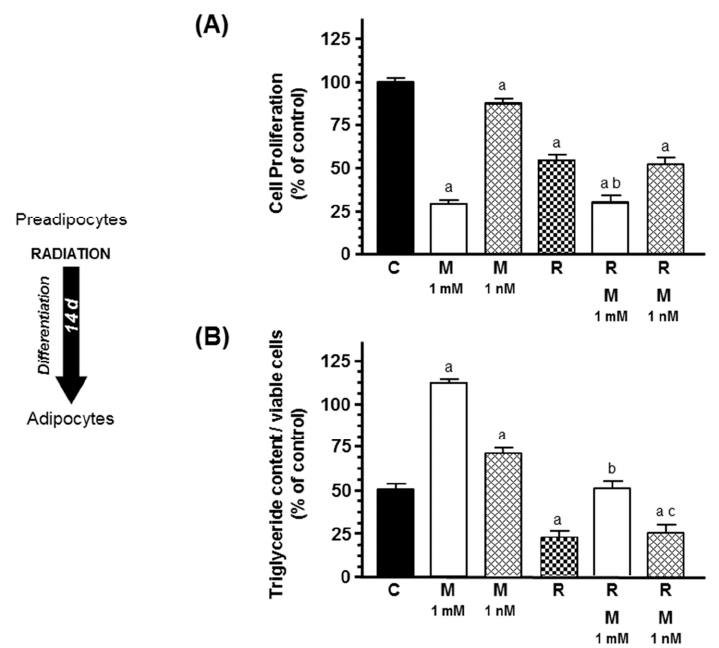
Figure 4. Effects of melatonin (1 mM or 1 nM) on radiation-induced changes on (A) cell proliferation and (B) intracytoplasmic triglyceride content, during the course of differentiation of human breast adipocytes. Cell proliferation was quantified by the MTT method and triglyceride accumulation using the Oil Red O staining method. Data are expressed as the percentage of the control group (mean ± SEM). a, p < 0.001 vs. C; b, p < 0.001 vs. R; c, p < 0.001 vs. R & M 1 mM. C: control, M: melatonin, R: radiation.